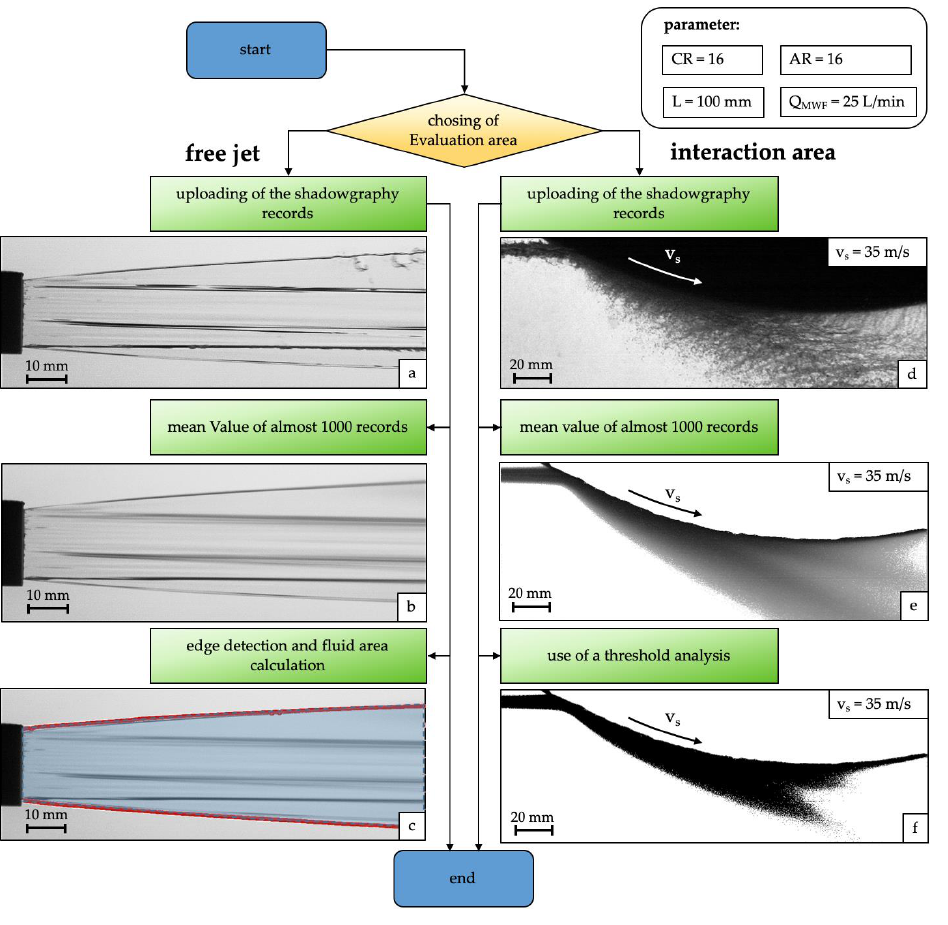
Figure 6. Flowchart for the evaluation of the shadowgraphy recordings, ( a – c ) evaluation steps of the free jet, ( d – f ) evaluation steps of the interaction area.